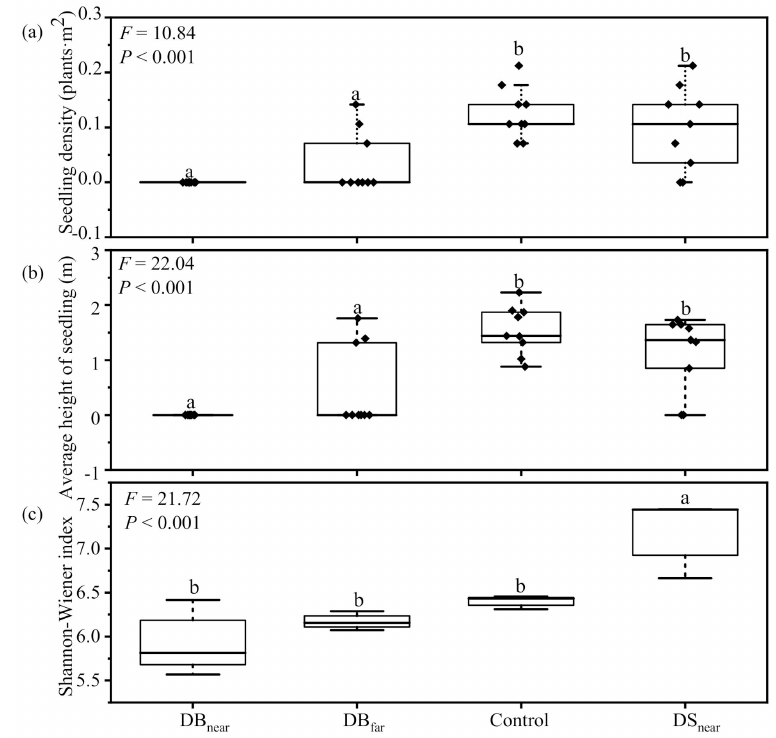
Figure 3. Differences in P. euphratica seedling density, height, and soil fungal diversity among the four plot types: ( a ) seedling density; ( b ) average seedling height; ( c ) soil fungal diversity. F and p -value are the statistical results of a one-way ANOVA. DB near and DB far are the ringed plots and the cambered plots, and their radius around the big adults were 3 m and 6 m, respectively. DS near is the ringed plots, which were around the small adults with a radius of 3 m. Control was the circular plots of 3 m in radius situated more than 9 m away from trunks of both the big and small adult trees.